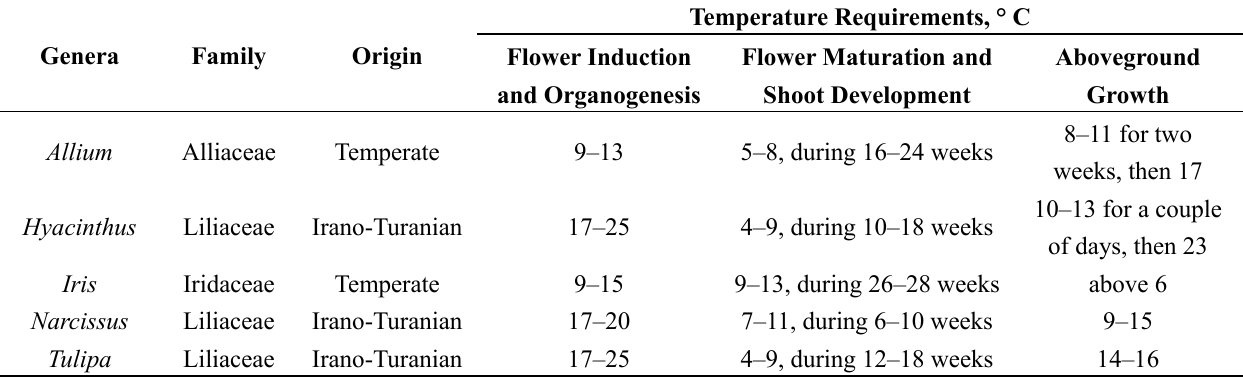
Table 1. Geographic origins of some ornamental geophytes and temperature requirements for their development